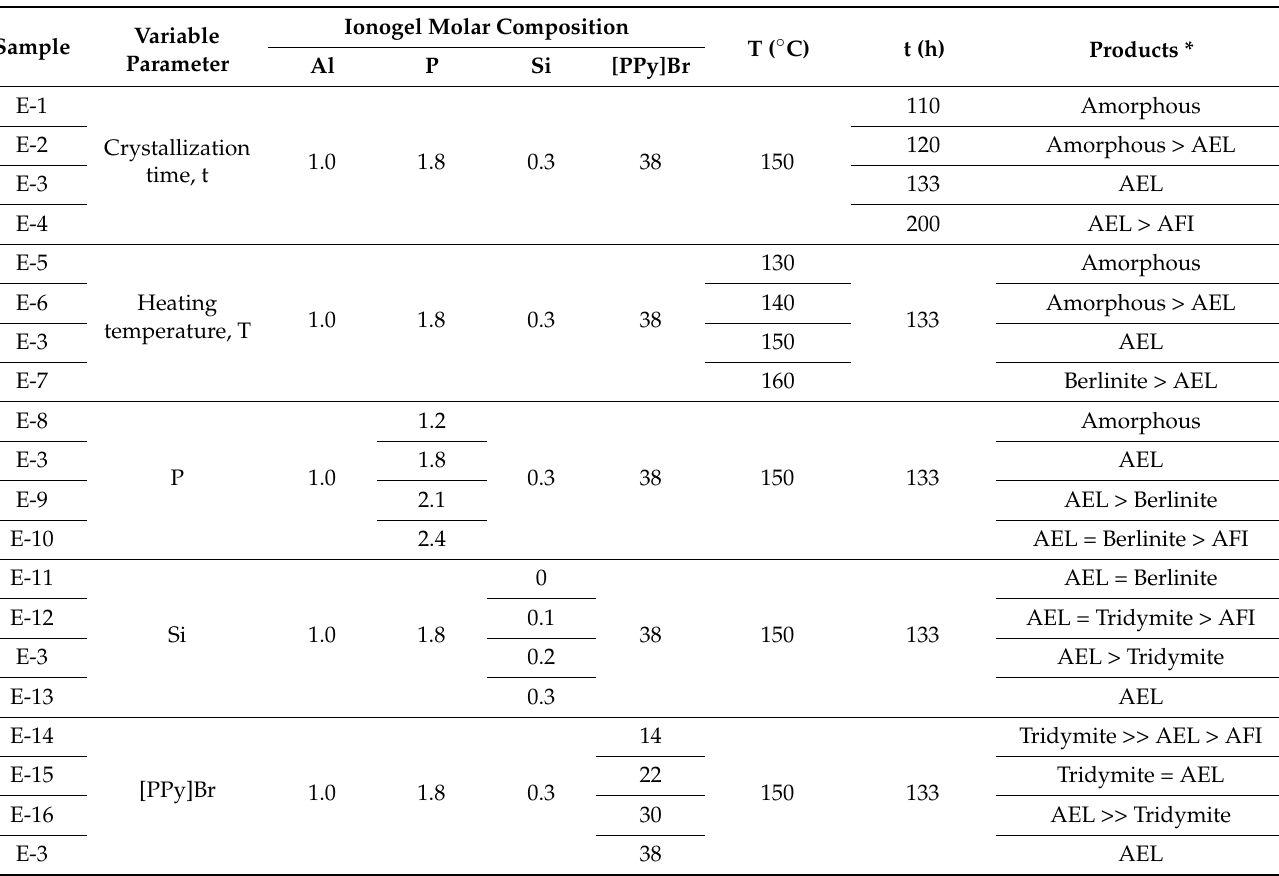
Table 2. The chemical composition of ionogel, crystallization time, heating temperature and phase products obtained for the synthesis parameters effect study.